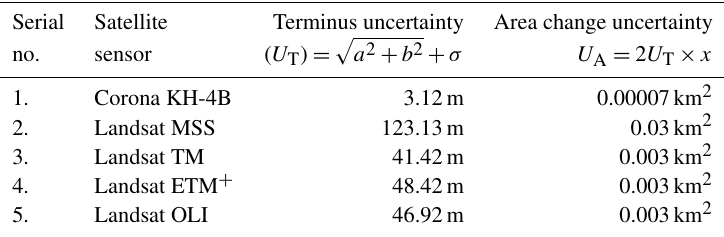
Table 2. Terminus and area change uncertainty associated with the satellite dataset as defined by Hall et al. (2003). U T : terminus uncertainty; U A : area change uncertainty; x : spatial resolution; σ : registration